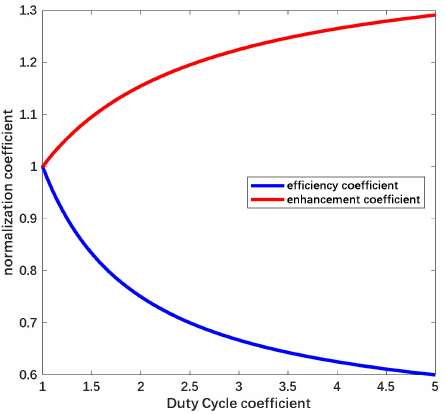
Figure 7. Relationship between the duty cycle of the signal and the coefficient of efficient force and